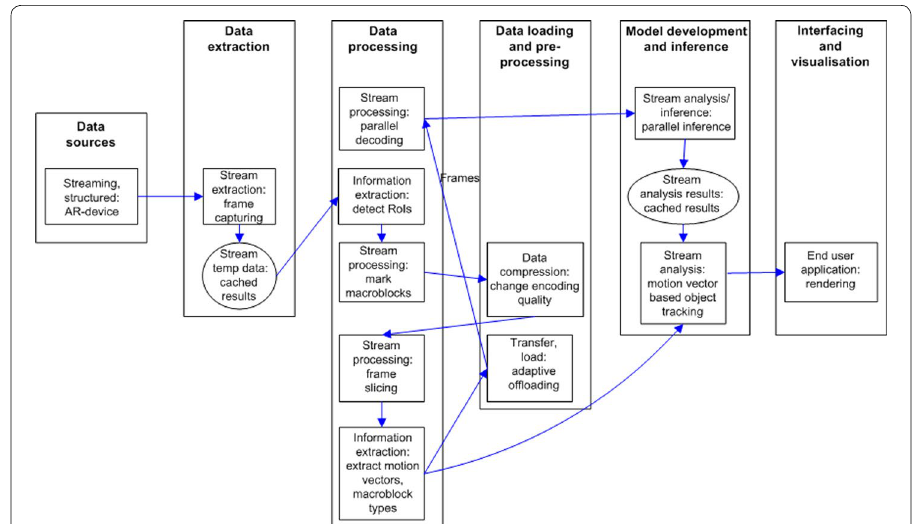
Fig. 12 The mapping of “Edge Assisted Real-time Object Detection for Mobile Augmented Reality” [29] to the big data